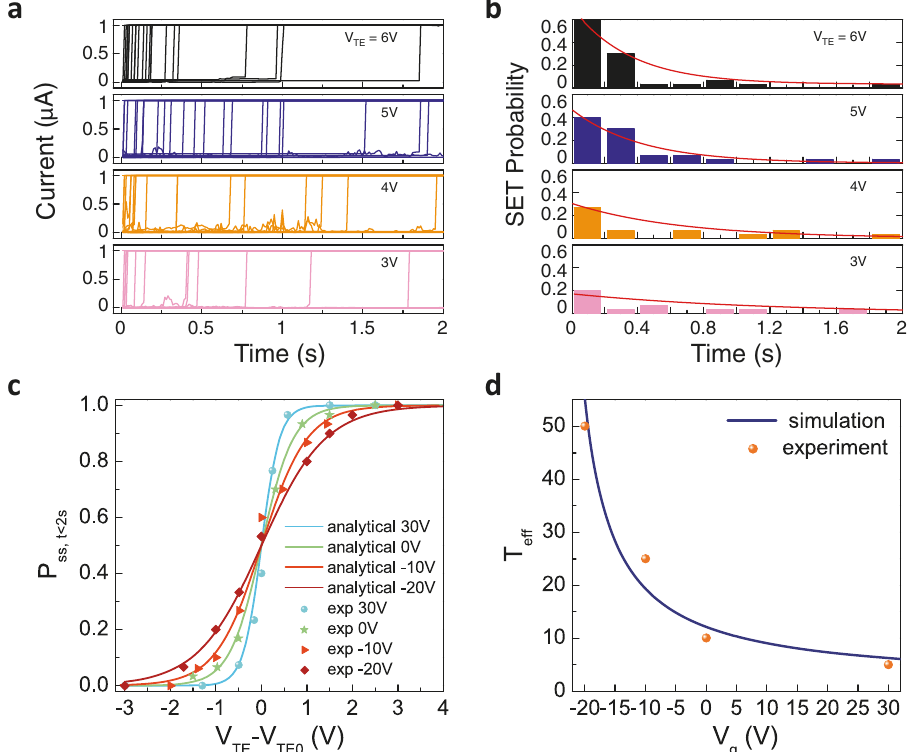
Fig. 2 Sampling of exponential-class sigmoidal distribution. a The set process under different V TE . The initial state is reset to high-resistance state and a bias V TE is applied to the device for 2 s. b The experimentally extracted probability distribution of the bias time until set occurrence for V TE = 3 V, 4 V, 5 V, and 6 V, respectively. c P ss,t<2s as a function of the V TE under different gate voltages, showing exponential-class sigmoidal distribution function. Experimental results are shown as data symbols, and the analytical model fi t is shown in lines. d Experimental results (dots) and model fi t (line) showing the relation between T eff and the gate bias V g